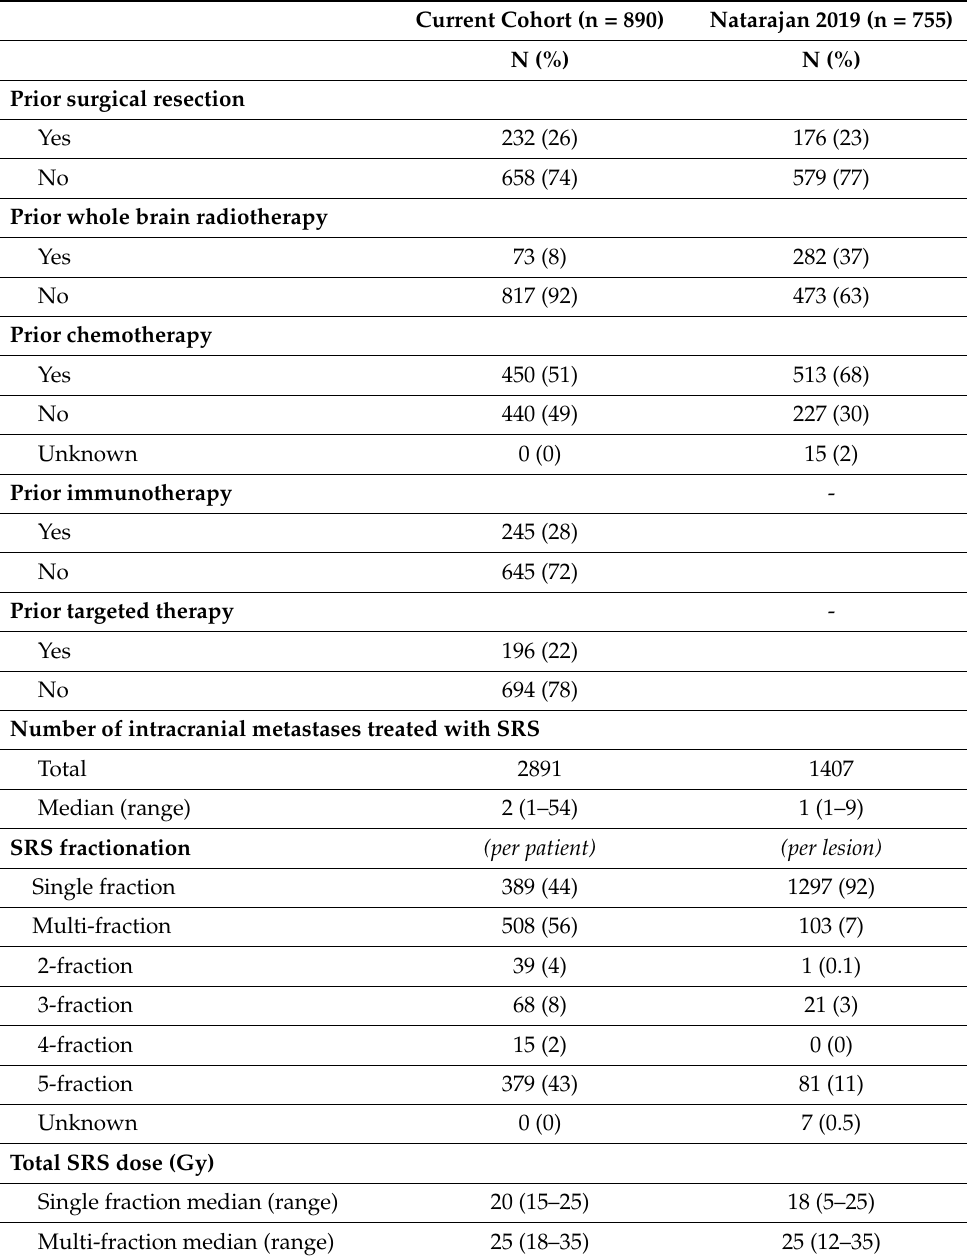
Table 2 summarizes treatment characteristics for 2891 BMs across 890 patients in comparison to those reported by Natarajan and colleagues [12]. Prior WBRT and surgical resection were performed in 26% and 8% of patients, respectively. In total, 63% of patients completed any systemic therapy prior to SRS, including cytotoxic chemotherapy (51%), immunotherapy (28%), and molecularly targeted therapy (22%). Multi-fractionated SRS was used for at least one BM in 56% of cases, with single- and multi-fraction SRS doses ranging from 15–25 Gy and 18–35 Gy, respectively. Per the IP nomogram, 53% of patients were deemed high-risk (Table 3), primarily due to ≥ 2 non-melanoma BMs (50% of all patients) in the context of metastatic disease <5 years from cancer diagnosis (91%). Table 2. Treatment characteristics across all patients, with reference comparison to the cohort from [12]. Abbreviations: Interquartile range, IQR; stereotactic radiosurgery,